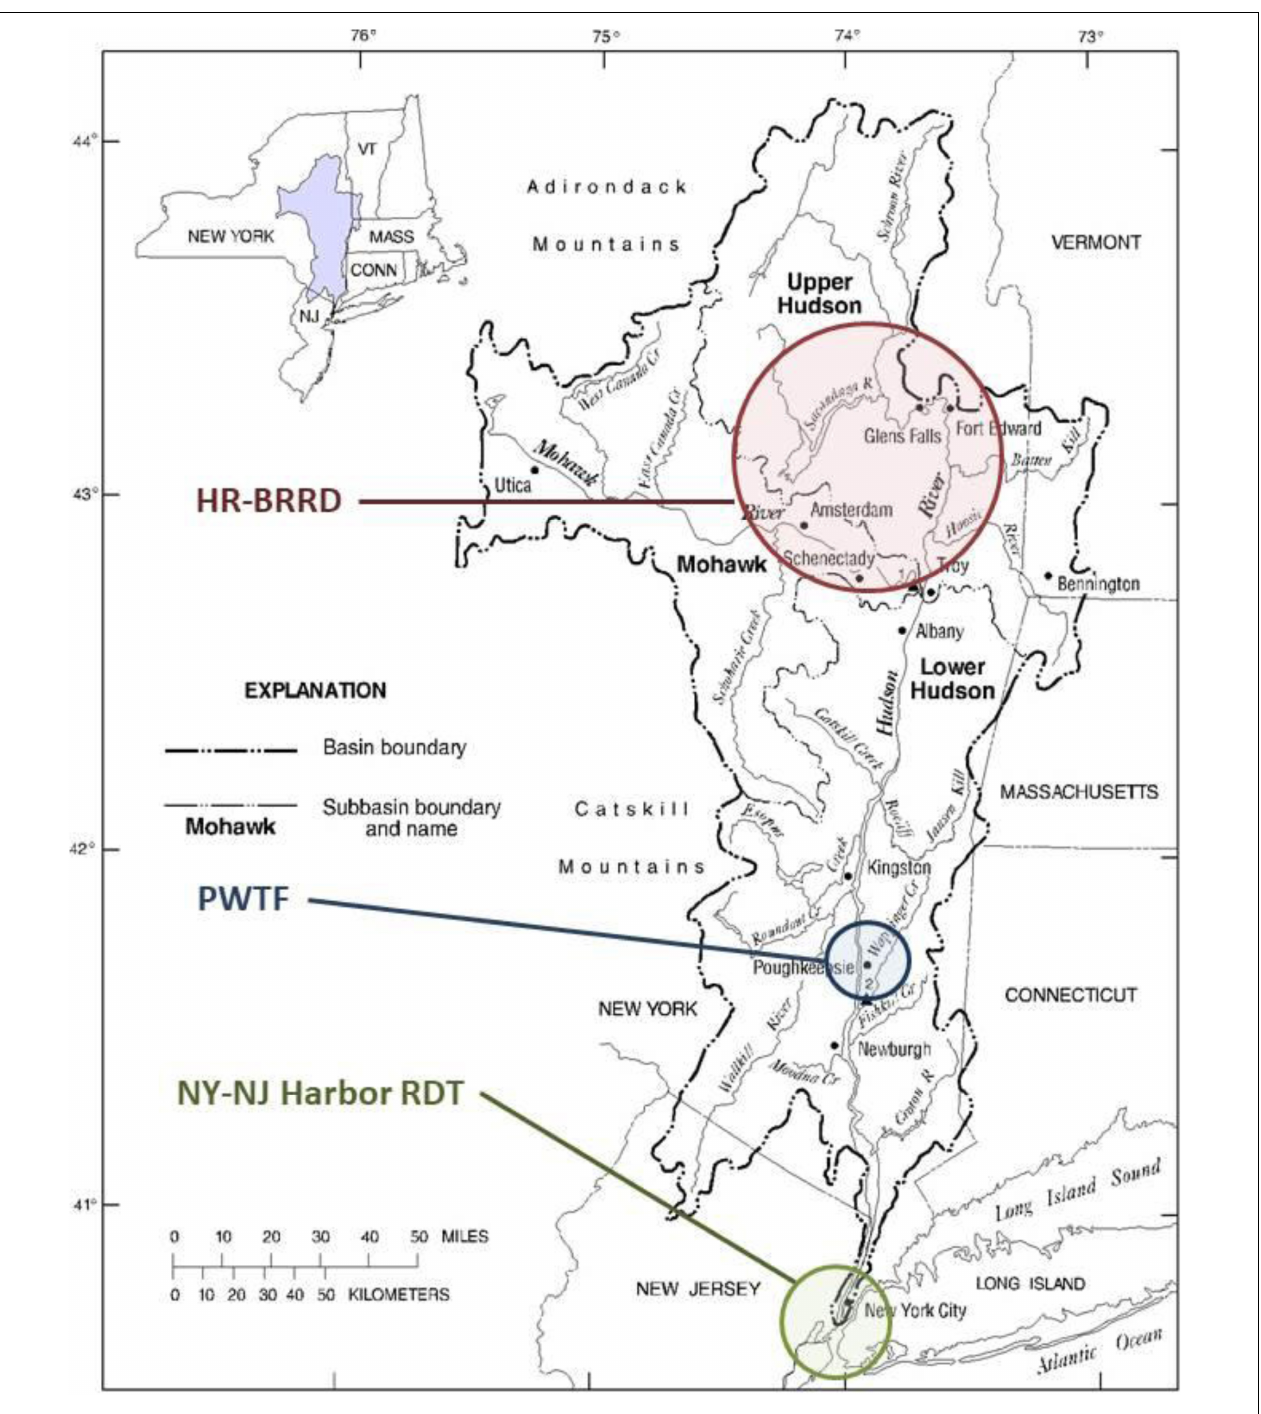
FIGURE 2 | Three seemingly detached management regimes for different ecosystem services in the Hudson River: (a) channel deepening: New York-New Jersey Harbor Regional Dredging Team (NY-NJ Harbor RDT); (b) drinking water withdrawals: Poughkeepsie Water Treatment Facility (PWTF); and (c) hydroelectric power and regulation of downstream freshwater flows: Hudson River-Black River Regulating District (HR-BRRD). Base map from the US Army Corps of Engineers (1982).